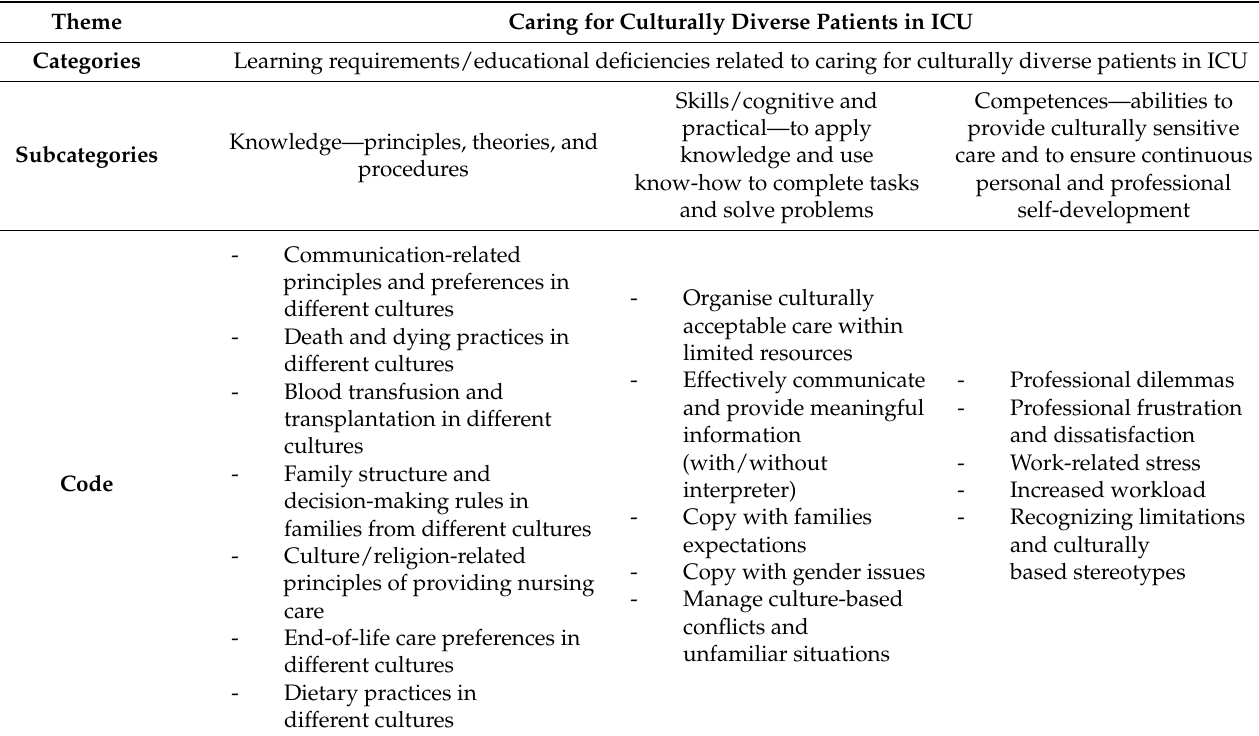
Table 8. Educational needs related to caring for culturally diverse patients in ICU. Theme Caring for Culturally Diverse Patients in ICU